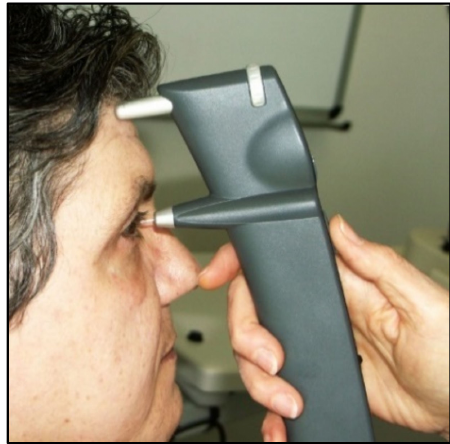
Figure 11. iCare rebound tonometer.